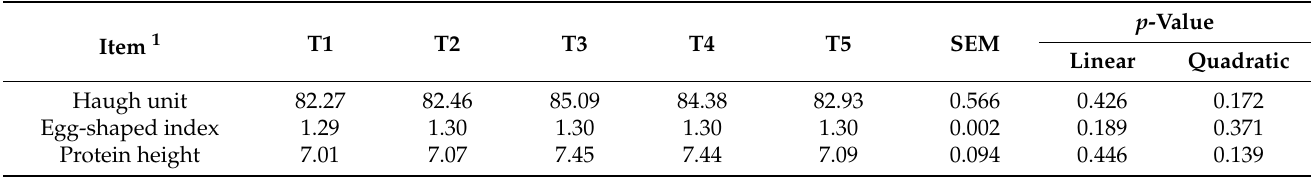
Table 4. Effects of casein phosphopeptide (CPP) on Haugh unit, protein height, and egg shape index of laying hens.